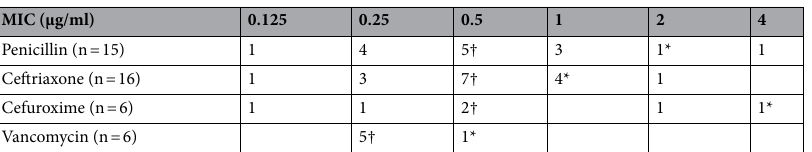
Table 4. Minimal inhibitory concentration of Streptococcus pneumoniae in patients with endophthalmitis. MIC minimal inhibitory concentration. *Indicates MIC 90 values. † Indicates MIC 50 values.